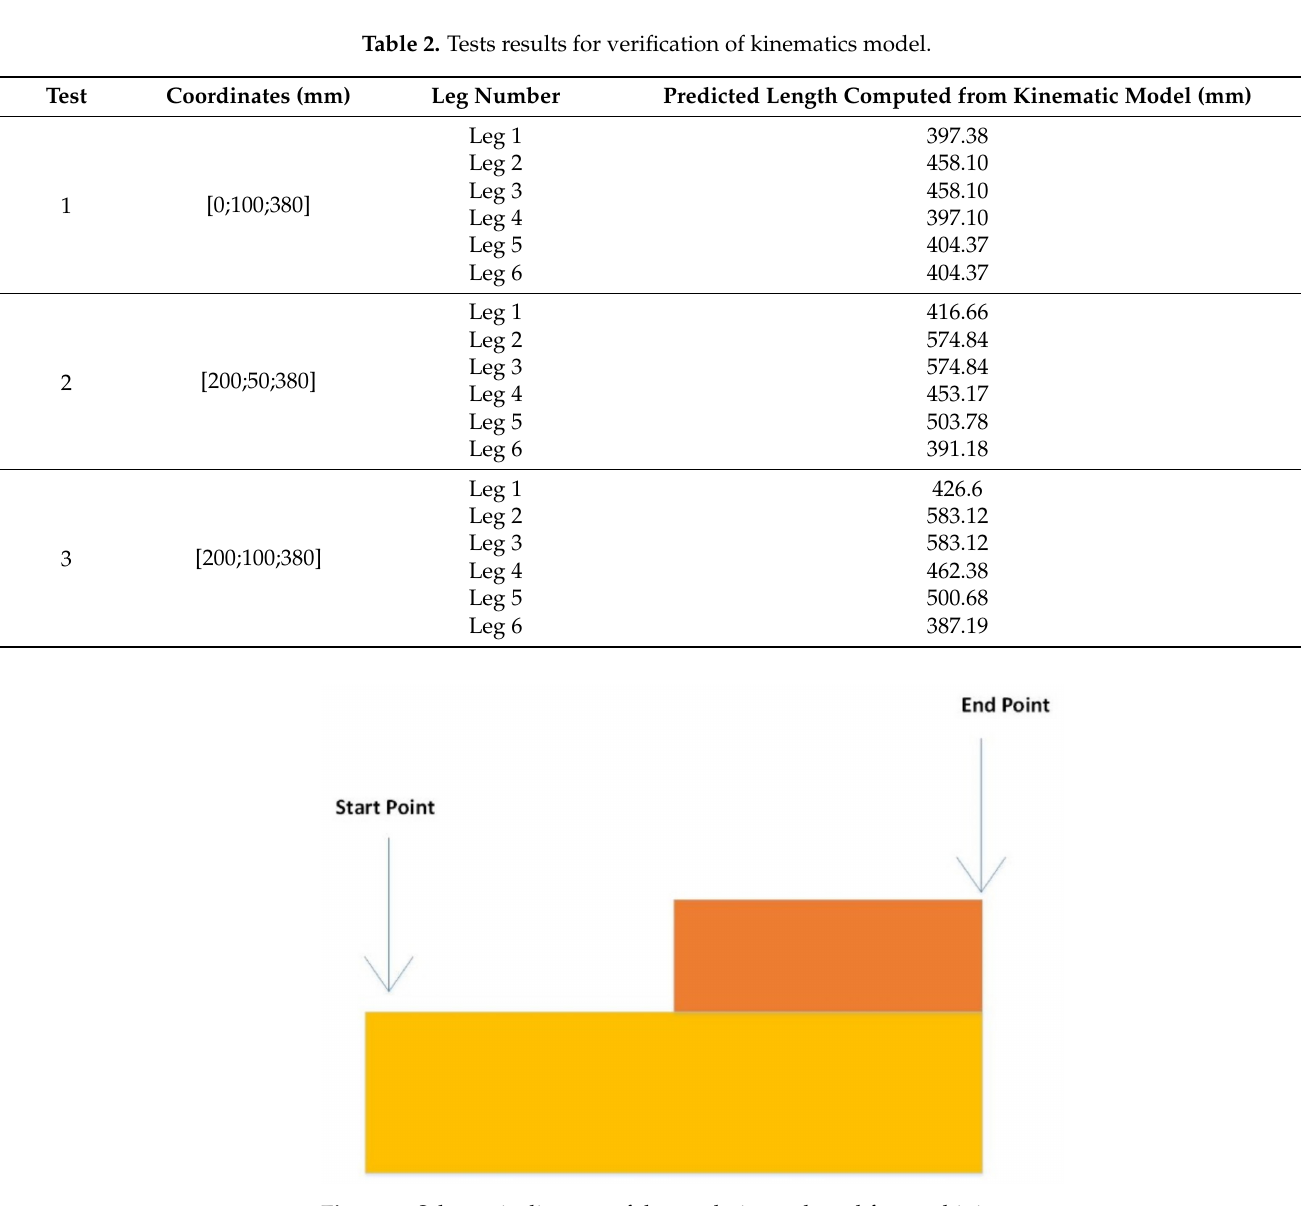
Figure 9. Schematic diagram of the workpiece selected for machining. Table 3. Description of tests conducted on the